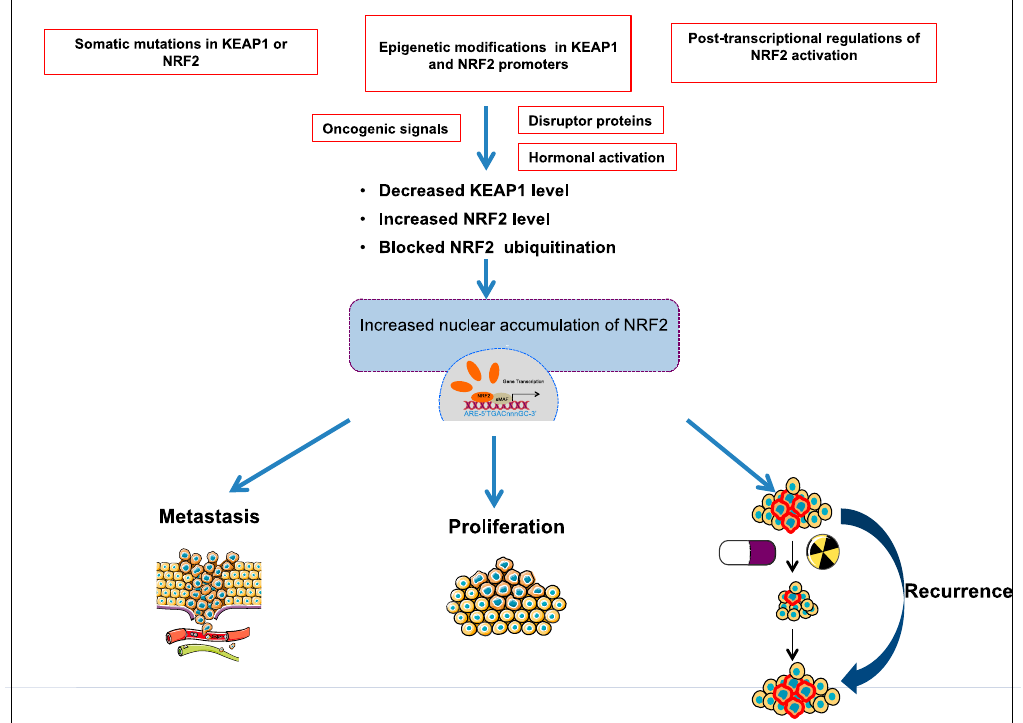
Figure 3. Different molecular mechanisms are responsible for activation of NRF2-KEAP1 pathway in cancer; somatic mutations in KEAP1 or NRF2; epigenetic modifications in KEAP1 and NRF2 promoter; post-transcriptional activation of NRF2; oncogenic signals; hormonal activation.